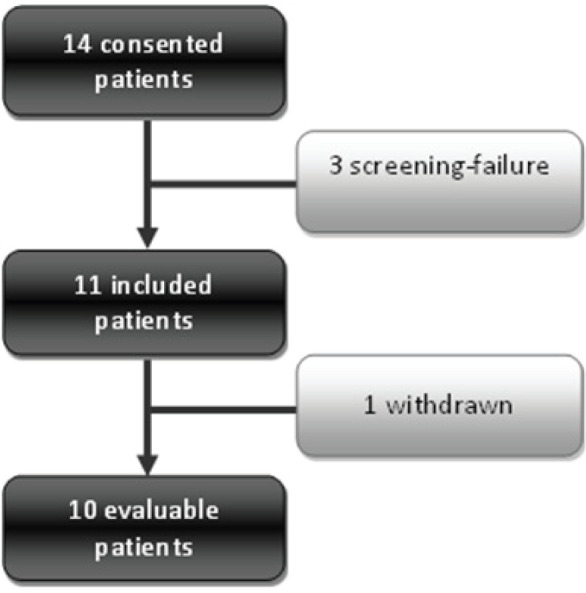
Consort diagram. Consort diagram of patients included in the study from 2012 to 2014. One patient was withdrawn due to performance status deterioration before CCRT.